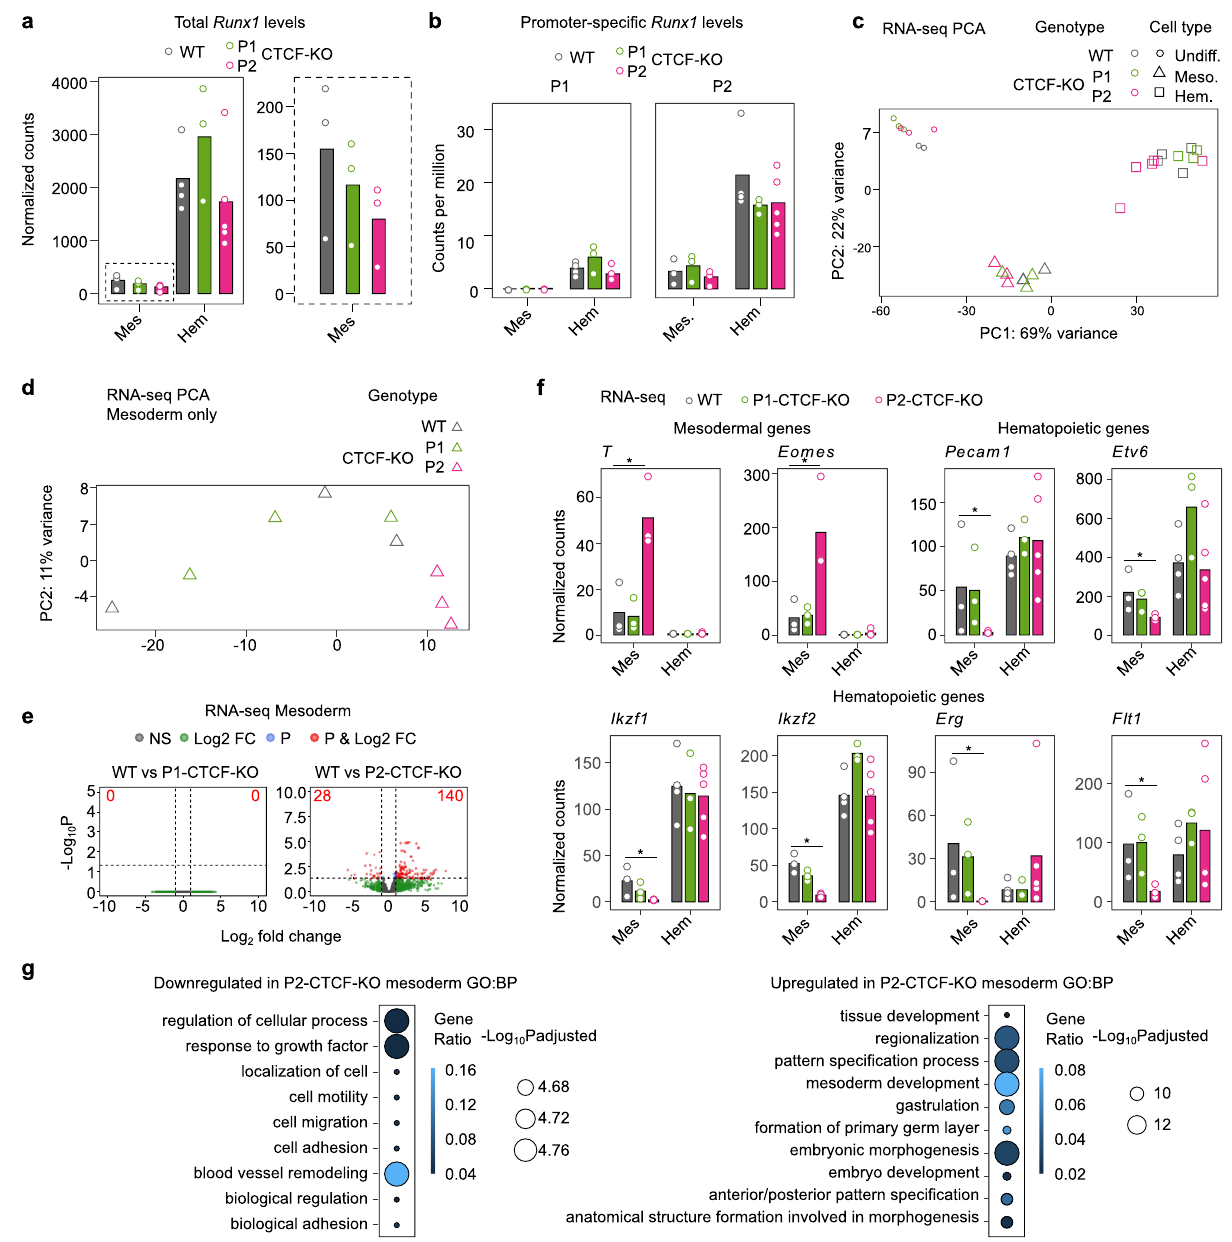
Fig. 5 Runx1 spatiotemporal expression is slightly altered after loss of P2-proximal CTCF. a Total Runx1 levels in poly(A)-minus RNA-seq in the cell types and genotypes indicated. The expanded graph with a dashed outline shows data just for mesodermal cells on a different axis. b Promoter-speci fi c Runx1 levels for each promoter in the cell types and genotypes indicated. c PCA of all poly(A)-minus RNA-seq replicates. d PCA of mesoderm RNA-seq samples. e Volcano plots showing differentially expressed genes (DEGs, DESeq2 adjusted two-sided p < 0.05, fold change >1) in P2-CTCF-KO compared to wild- type mesoderm. f Expression of lineage marker genes across differentiation in the genotypes indicated (*, DESeq2 adjusted two-sided p -values: T (0.048), Eomes (0.0021), Pecam1 (0.037), Etv6 (0.043), Ikzf1 (0.016), Ikzf2 (1.1 × 10 − 5 ), Erg (0.0079), Flt1 (0.0078), fold change >1). g GO term biological processes associated with the DEG list between wild-type and P2-CTCF-KO mesoderm. Gene ratios and − log 10 p -values adjusted using the Benjamini – Hochberg method are indicated for signi fi cantly enriched (goseq p -values adjusted with Benjamini – Hochberg procedure p < 0.05) GO terms. a – g Data were analyzed from n = 3 independent experiments for Wild type, P1-CTCF-KO, P2-CTCF-KO mesoderm, n = 4 independent experiments wild-type hematopoietic, n =